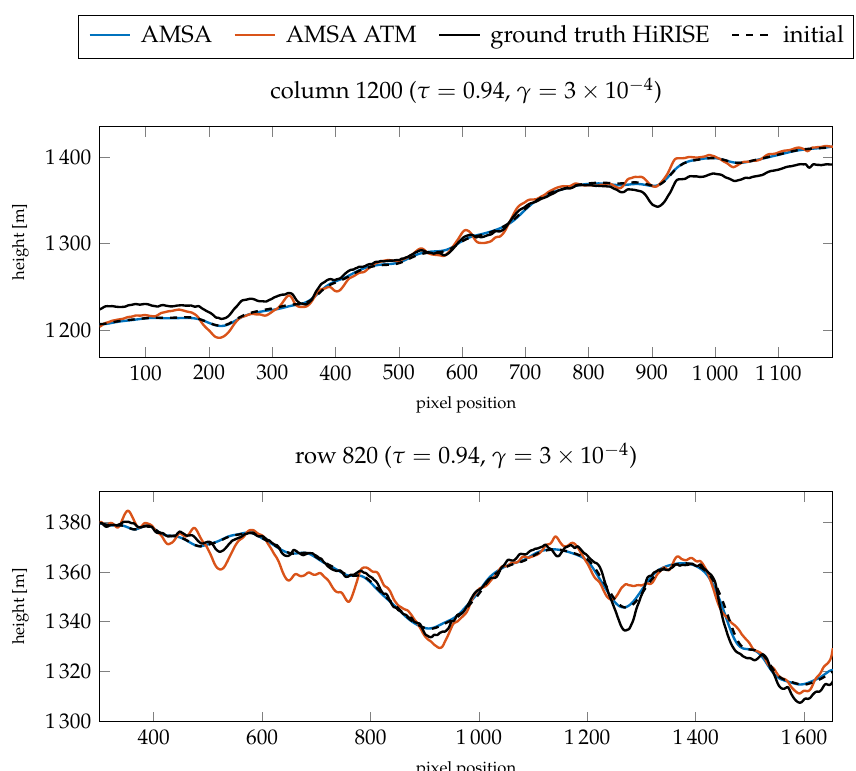
Figure A3. Absolute heights for image K13_058475_2232_XN_43N103W (bad atmospheric conditions) not displayed in the main text.